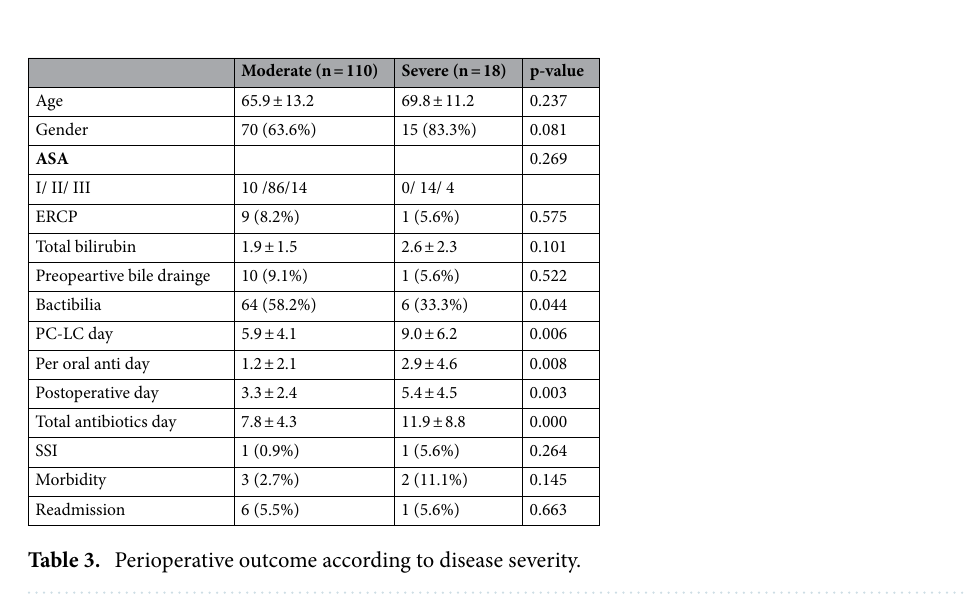
Table 2. Perioperative outcome according to bactibilia.